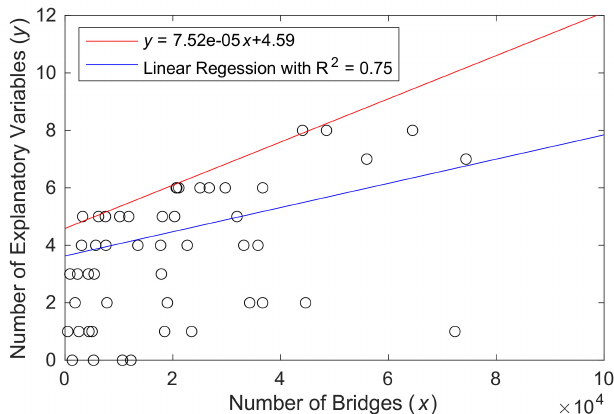
Figure 8. Number of optimal explanatory variables for all U.S. states to minimize the normalized prediction